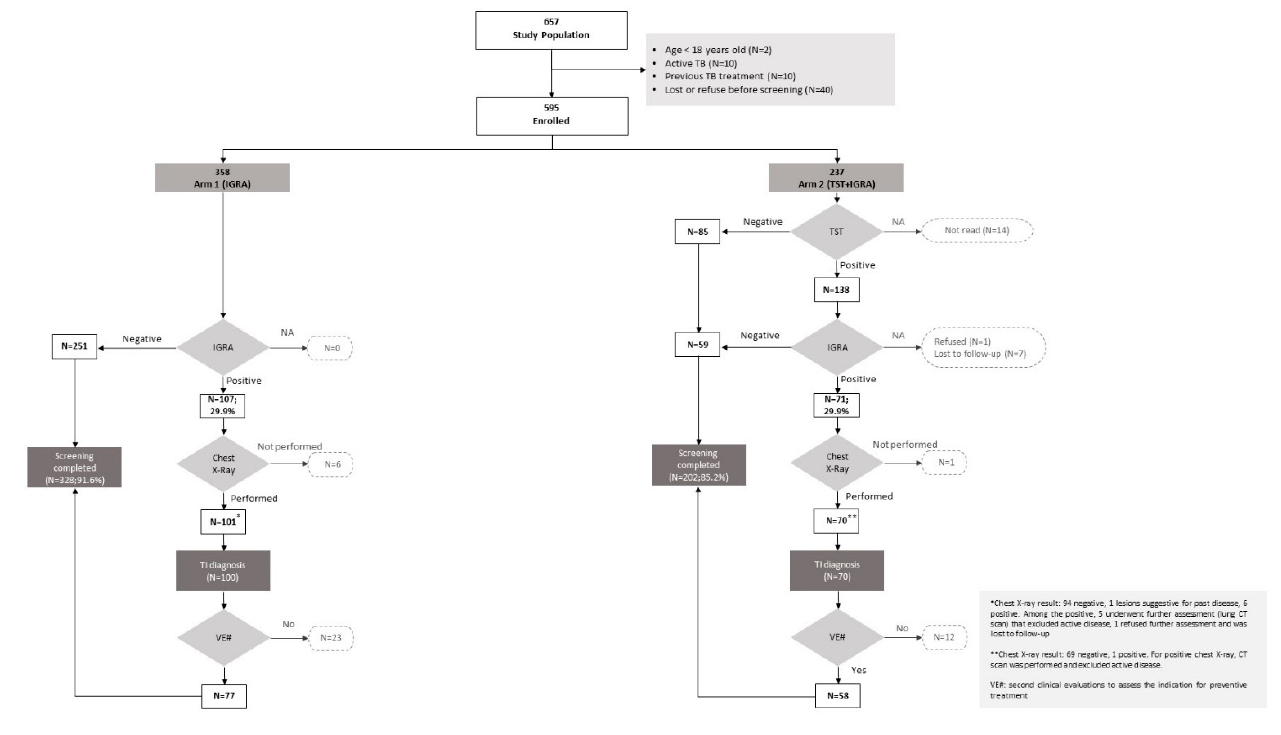
Figure 1. Screening cascade.